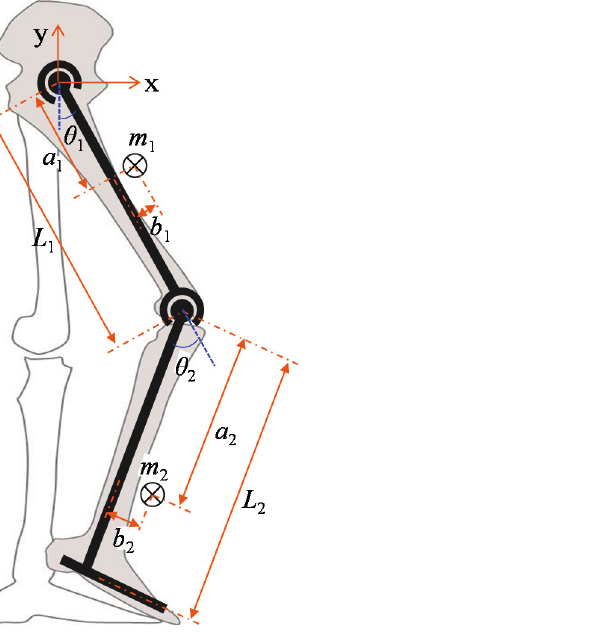
Figure 2. Schematic diagram of the link-segment model of a human lower limb wearing an